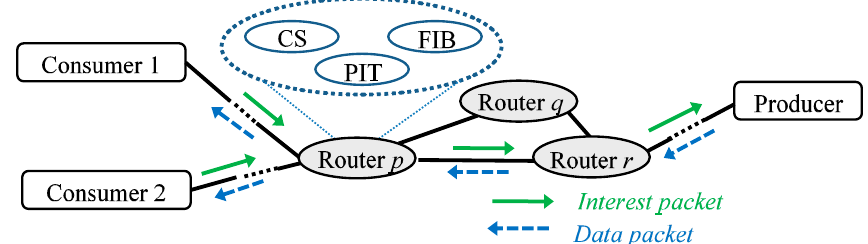
Figure 1. Overview of packet forwarding in named data networking (NDN). CS: content store. PIT: pending interest table. FIB: forwarding information base.